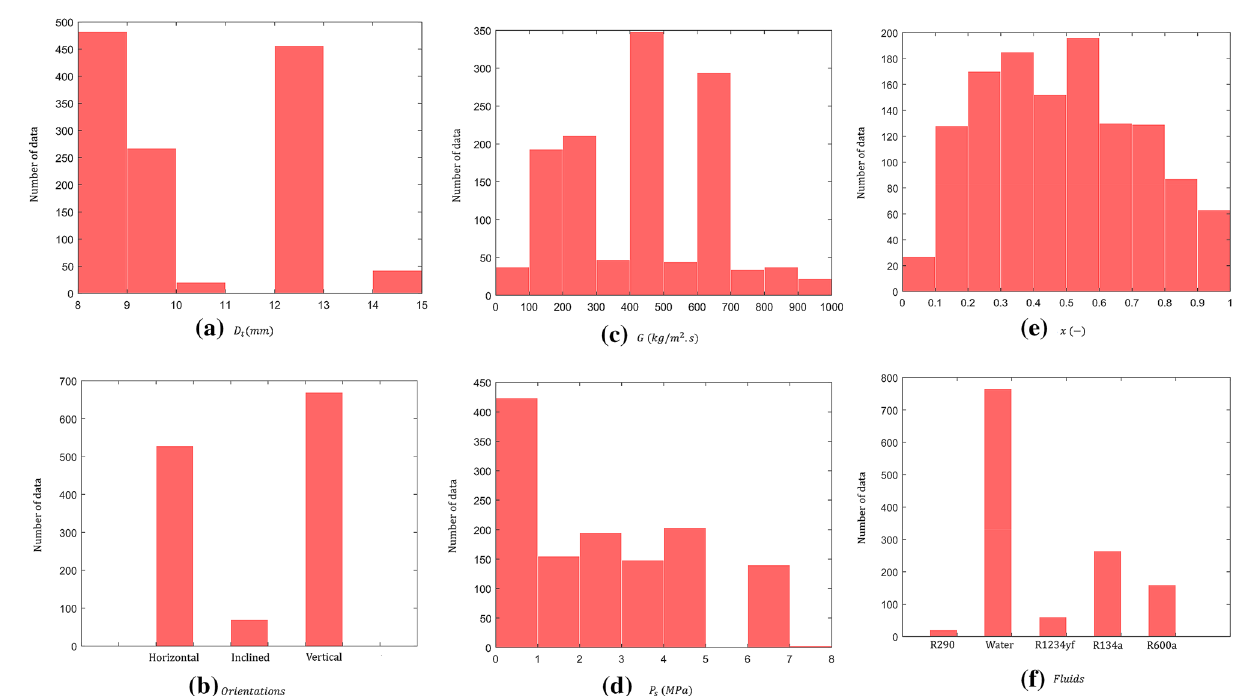
Figure 3. Data distribution of gathered data for two-phase FPD in helical coiled